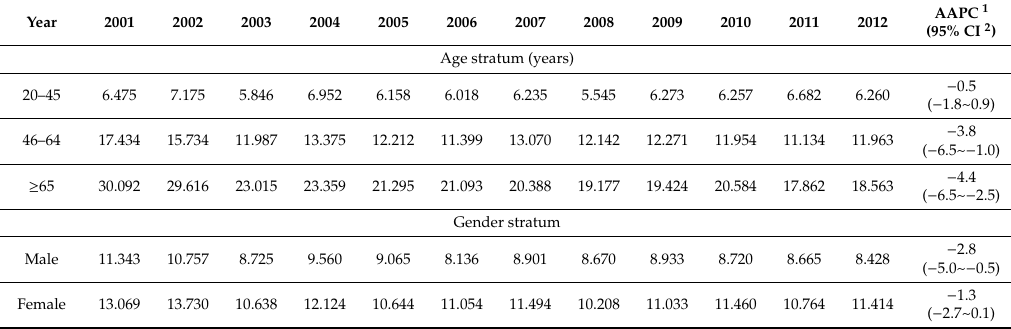
Table 3. Annual incidence of PSVT-related admission by age (1 / 100,000).